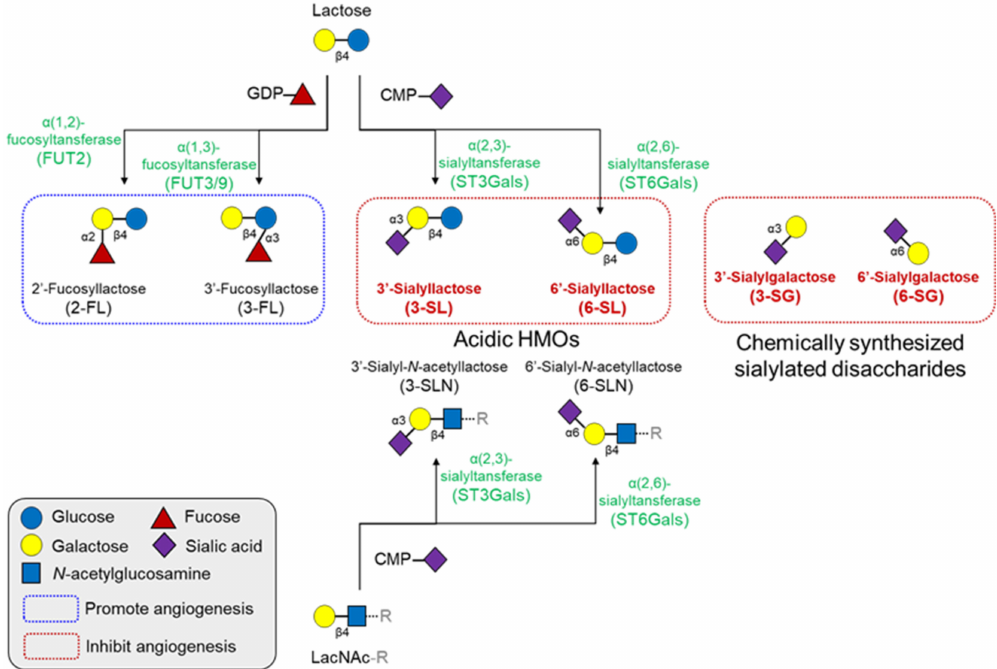
Figure 4. Structures and synthetic pathways of major HMOs and their effects on angiogenesis. All HMOs consist of a lactose core or LacNAc core, with a few exceptions. These cores can be enzymatically elongated in repeats of LacNAc. The elongated HMO chains can be further decorated with fucosylation or sialylation by fucosyltransferases or sialyltransferases, respectively. Fucosylated HMOs generally promotes angiogenesis, but several sialyllactose analogs inhibit angiogenesis. CMP, cytidine monophosphate; GDP, guanosine diphosphate; HMO, human milk oligosaccharides; LacNAc, N